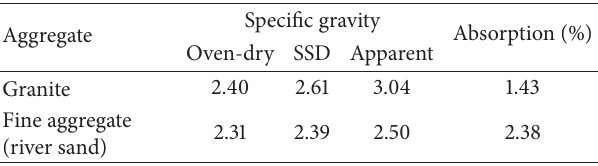
Table 1: Specific gravity and water absorption of coarse and fine aggregate.